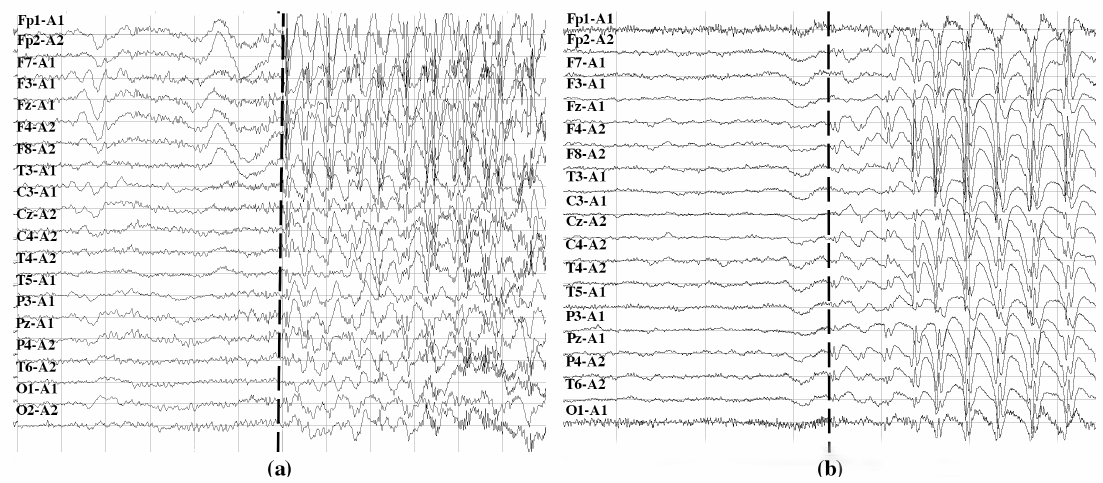
Figure 3. Examples of EEG signals recorded with monopolar montage with the reference electrode placed on the ipsilateral ear at the onset of focal ( a ) and generalized ( b ) seizures. In the two cases, seizure onsets are marked with dashed lines. It can be noticed that the epileptiform discharges begin in the left frontotemporal region with later bilateral synchronization in the right frontal region in ( a ), and in all brain areas at the same time in ( b